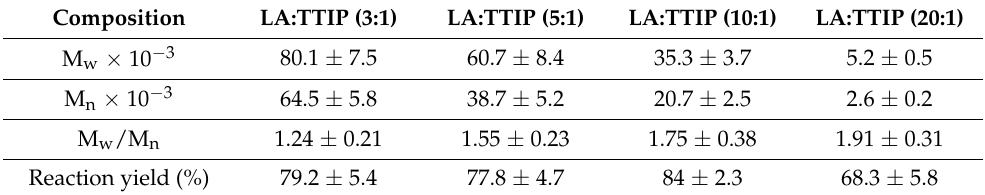
Table 1. Molecular weight characteristics and yield of the reaction product.